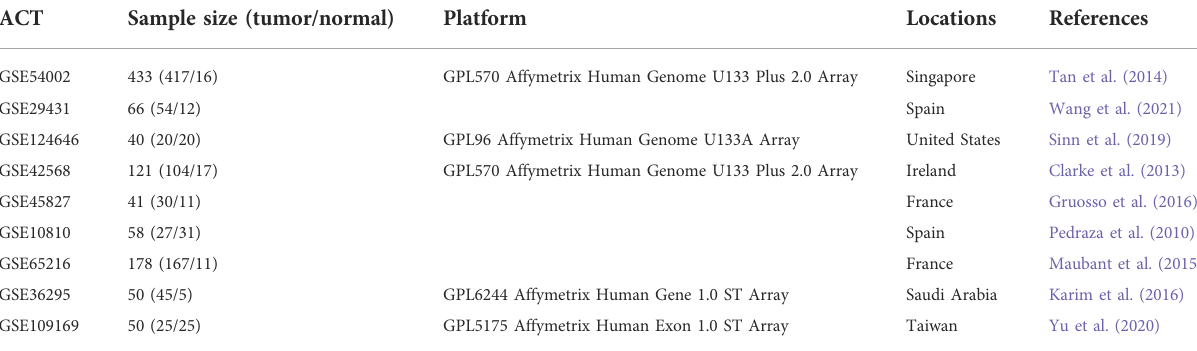
TABLE 1 Description of eight sets of gene expression pro fi les for BC analyzed in this study. ACT Sample size (tumor/normal)